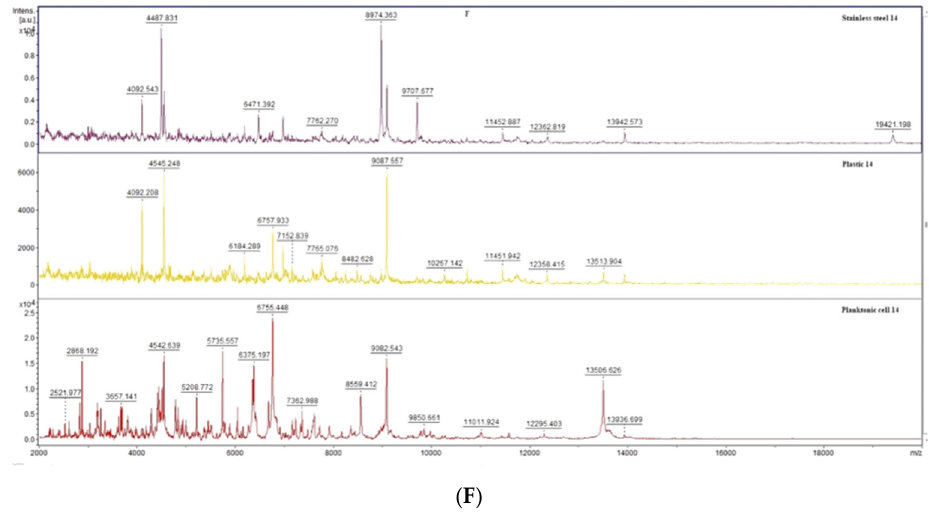
Figure 1. MALDI-TOF mass spectra of P. fluorescens biofilm development after EGEO exposition: ( A )—3rd day; ( B )—5th day; ( C )—7th day; ( D )—9th day; ( E )—12th day; ( F )—14th day.